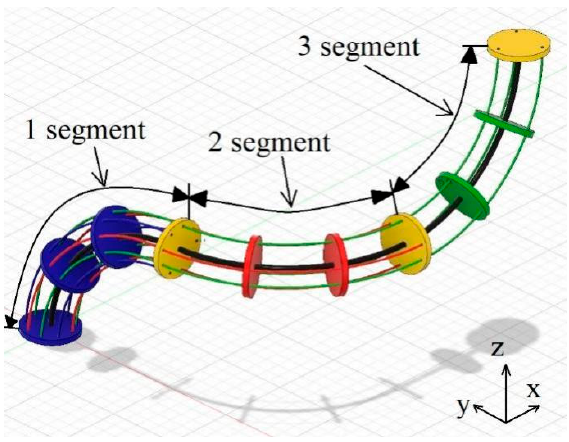
Figure 16. A trunk-type robot with three segments, each having three tendons.